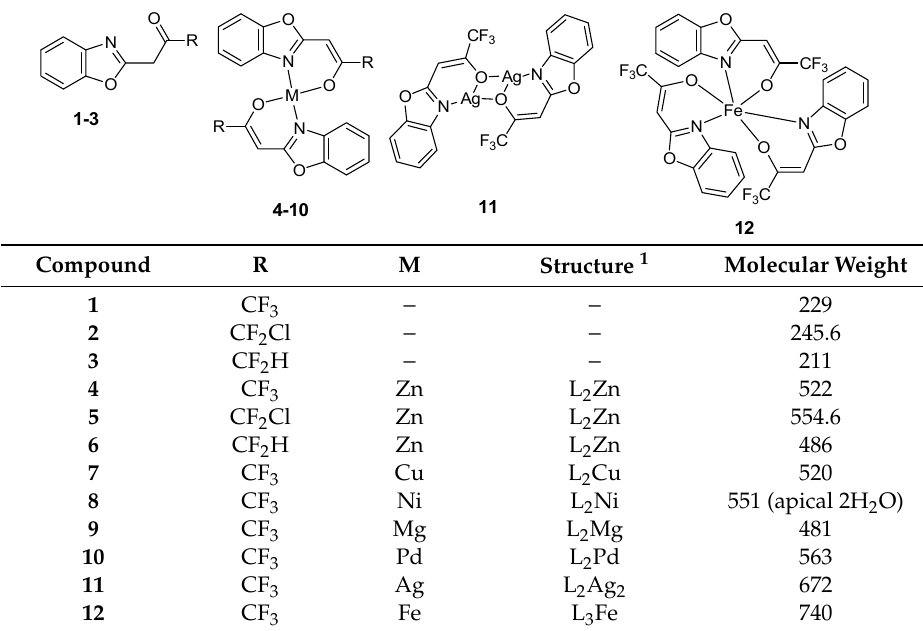
Table 6. Structures of ligands and their metal complexes.